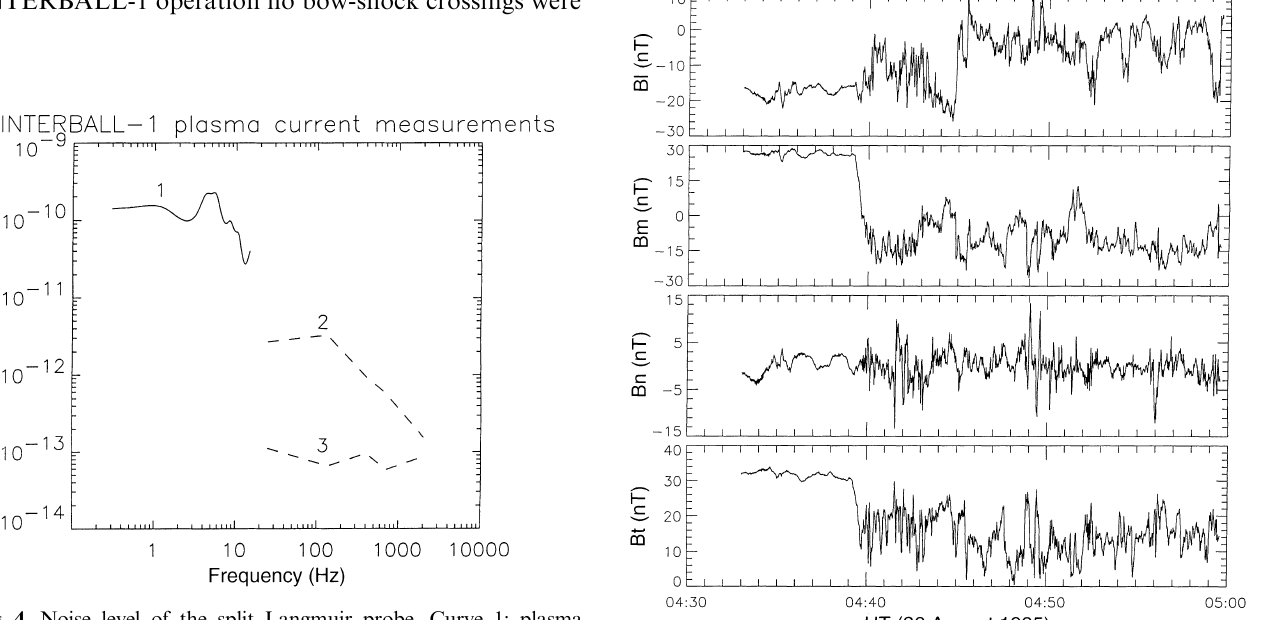
Fig. 4. Noise level of the split Langmuir probe. Curve 1: plasma current spectrum at the bow shock, detected by the PROGNOZ-10 plasma wave experiment; curve 2: bow shock plasma current spectrum from the filter bank; curve 3: split probe noise as measured by the filter bank in the quiet solar wind